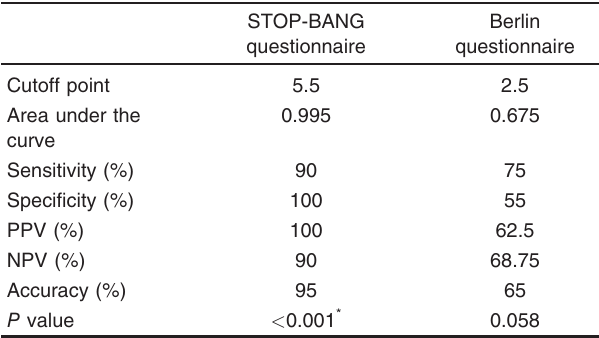
Table 3 Values of Berlin and STOP-BANG questionnaires in the diagnosis obstructive sleep apnea hypopnea syndrome patients